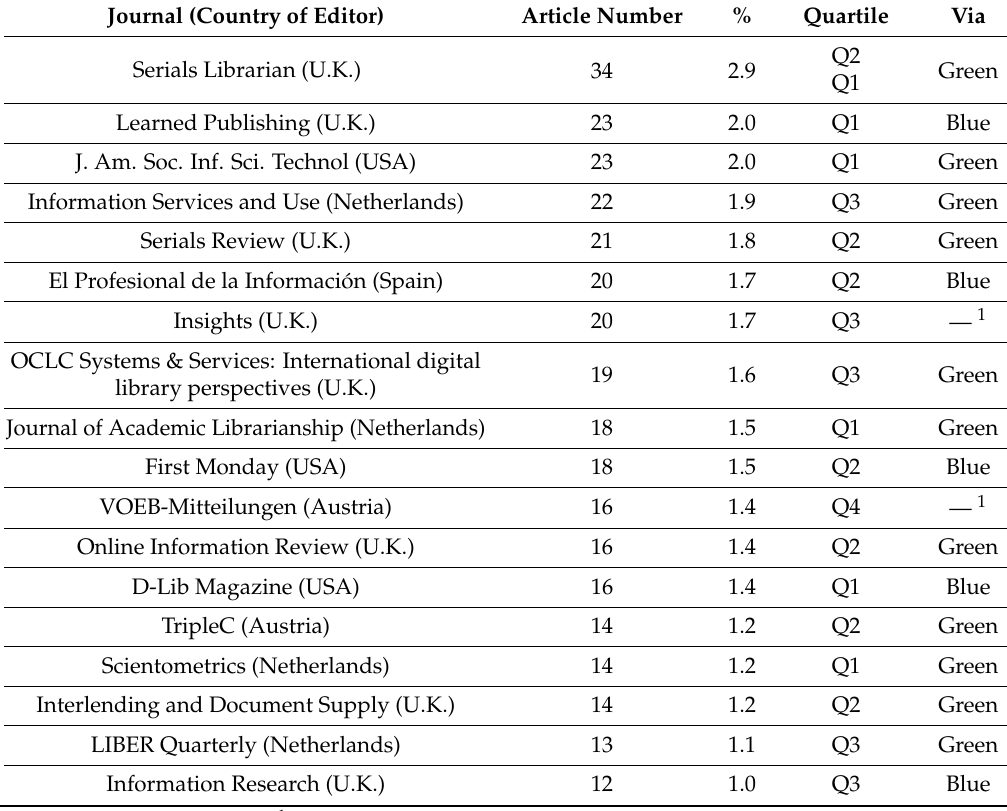
Table 3. Core journals on the dissemination of the analyzed scientific production.